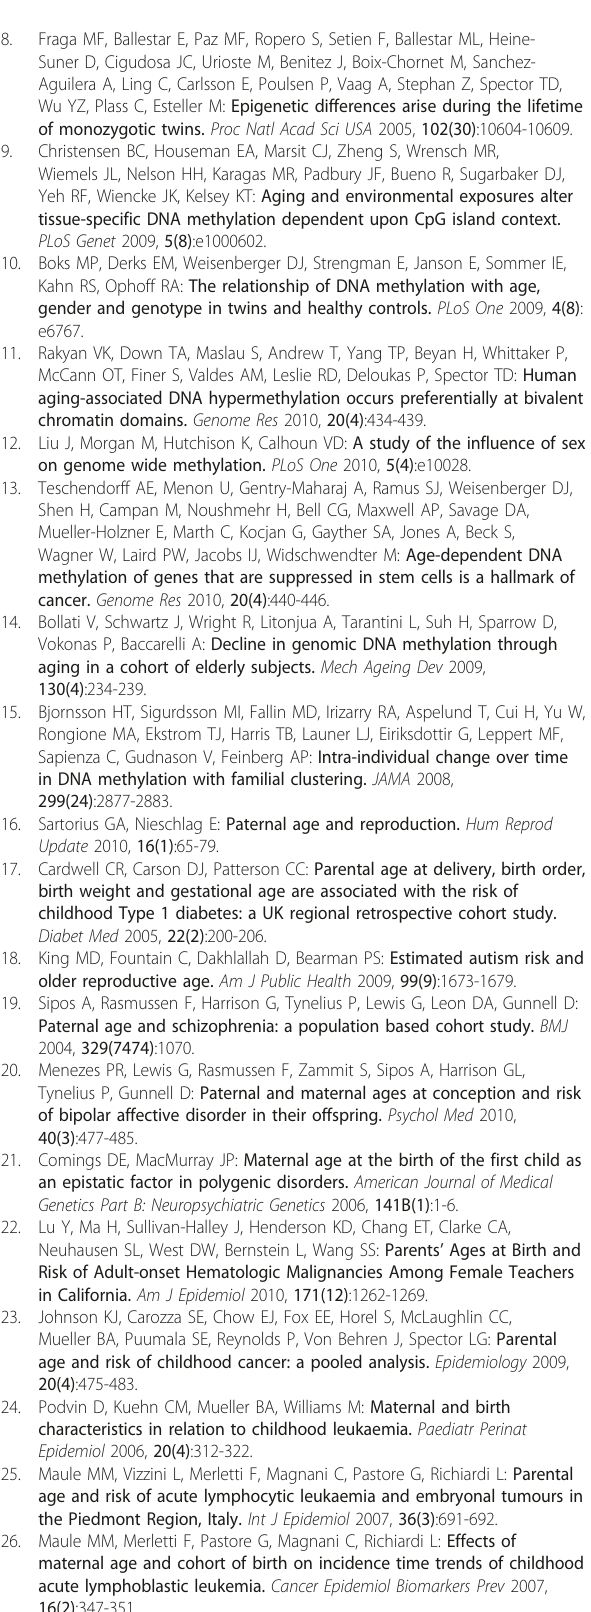
age at a q value of 6.69 × 10 -4 , corresponding to an expectation of one false positive and p = 9.55 × 10 -5 by DAVID. Additional file 5: Table S5 . List of 1,273 Humanmethylation27 array probes and 658 genes overlapping with blood cell type signature genes identified by Palmer et al. (2006. Cell-type specific gene expression profiles of leukocytes in human peripheral blood. BMC Genomics 7, 115).